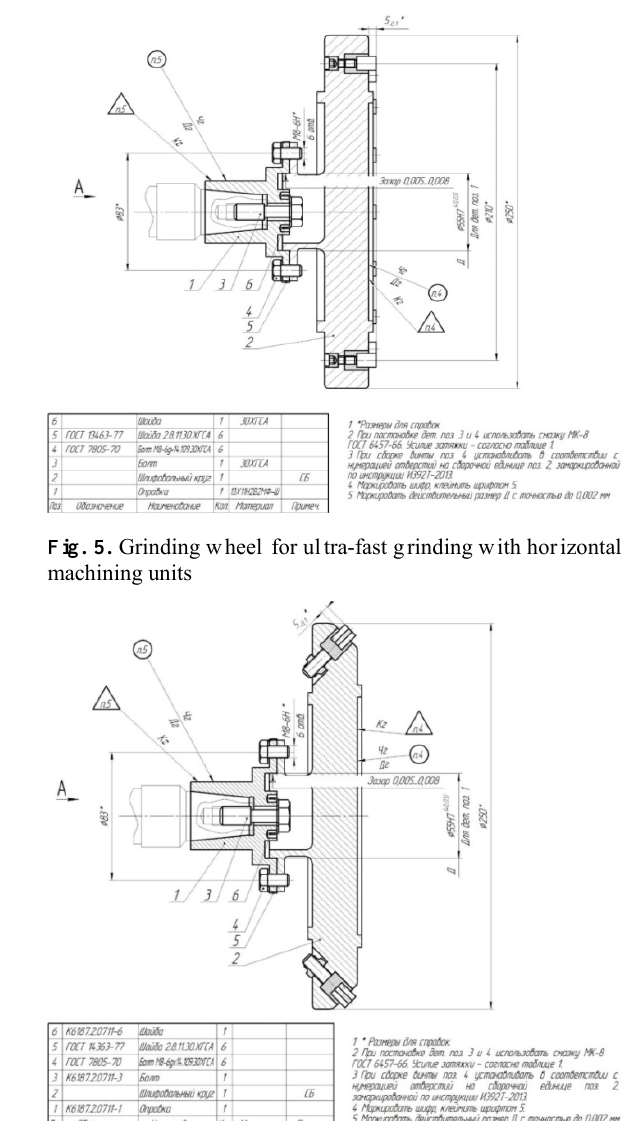
Fig. 6. Grinding wheel for ultra-fast grinding with 45 de gree grinding